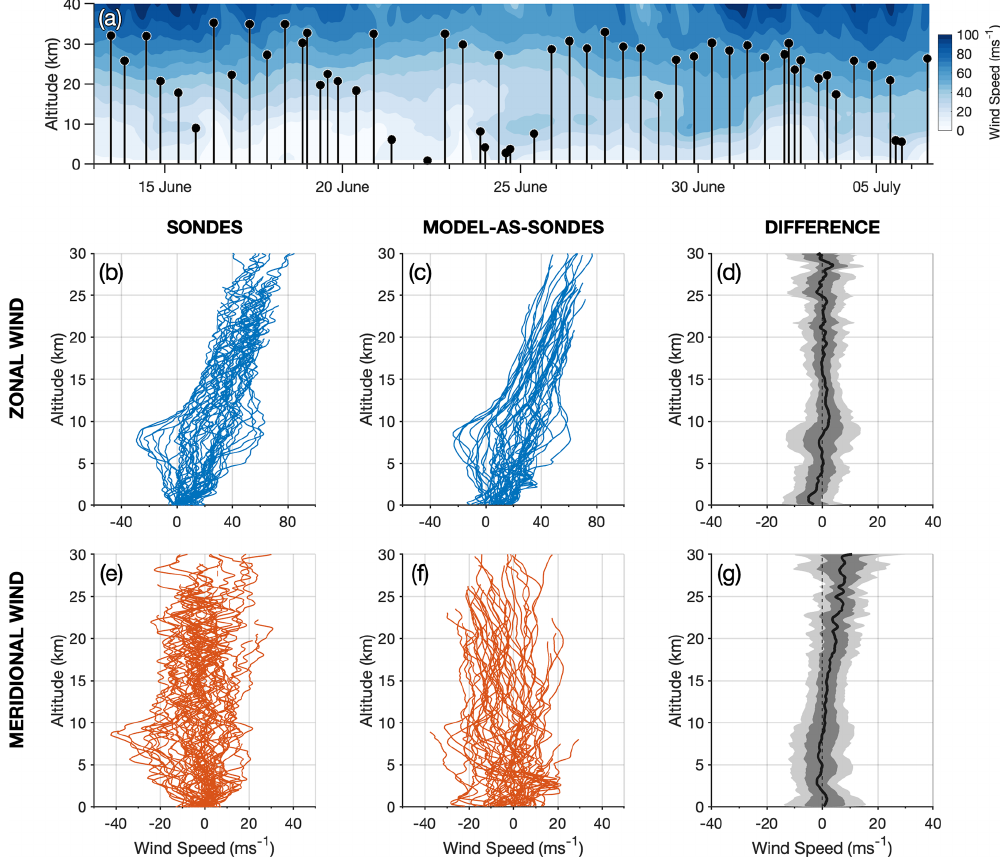
Figure 3. Comparison of wind speeds from the local-area model to coincident radiosonde observations launched from South Georgia during June–July 2015. Panel (a) shows launch times and maximum altitudes of the radiosonde observations (black lines), while coloured contours show the magnitude of the model wind speed for illustration. Panels (b, e, c, f) show profiles of zonal (blue) and meridional (orange) wind against height for the radiosonde measurements and the model wind, where the model wind has been evaluated along each radiosonde’s trajectory. Panels (d, g) show the mean difference (thick black line) between the radiosonde and model wind speeds (the former minus the latter) for each height, while dark grey and light grey shading indicates 1 and 2 standard deviations